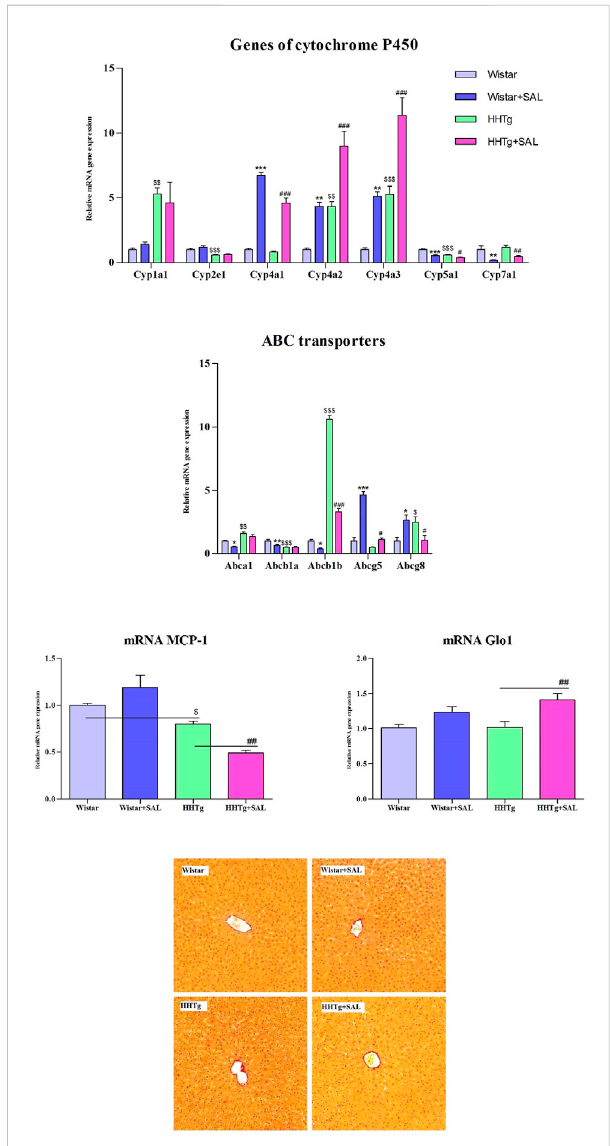
FIGURE 5 EffectofsalsalatetreatmentonhepaticrelativemRNAexpression of cytochrome P450 family proteins, ABC transporters, in fl ammation marker MCP-1 and dicarbonyl stress enzyme Glo-1 in Wistar control and hereditary hypertriglyceridemic (HHTg) rats. Values are expressed as mean ± SEM; n = 8; Effect of salsalate on histological evaluation in the liver. Histological images of liver parenchyma (picrosirius red (PSR) staining, 200x). We observed no apparent abnormityinanyexperimentalgroup.*denotessigni fi cancere fl ecting the effect of Wistar vs. Wistar + SAL, # denotes signi fi cance re fl ecting the effect of HHTg vs. HHTg + SAL, $ denotes signi fi cance re fl ecting the effect of Wistar vs. HHTg; * p < 0.05, ** p < 0.01, *** p <